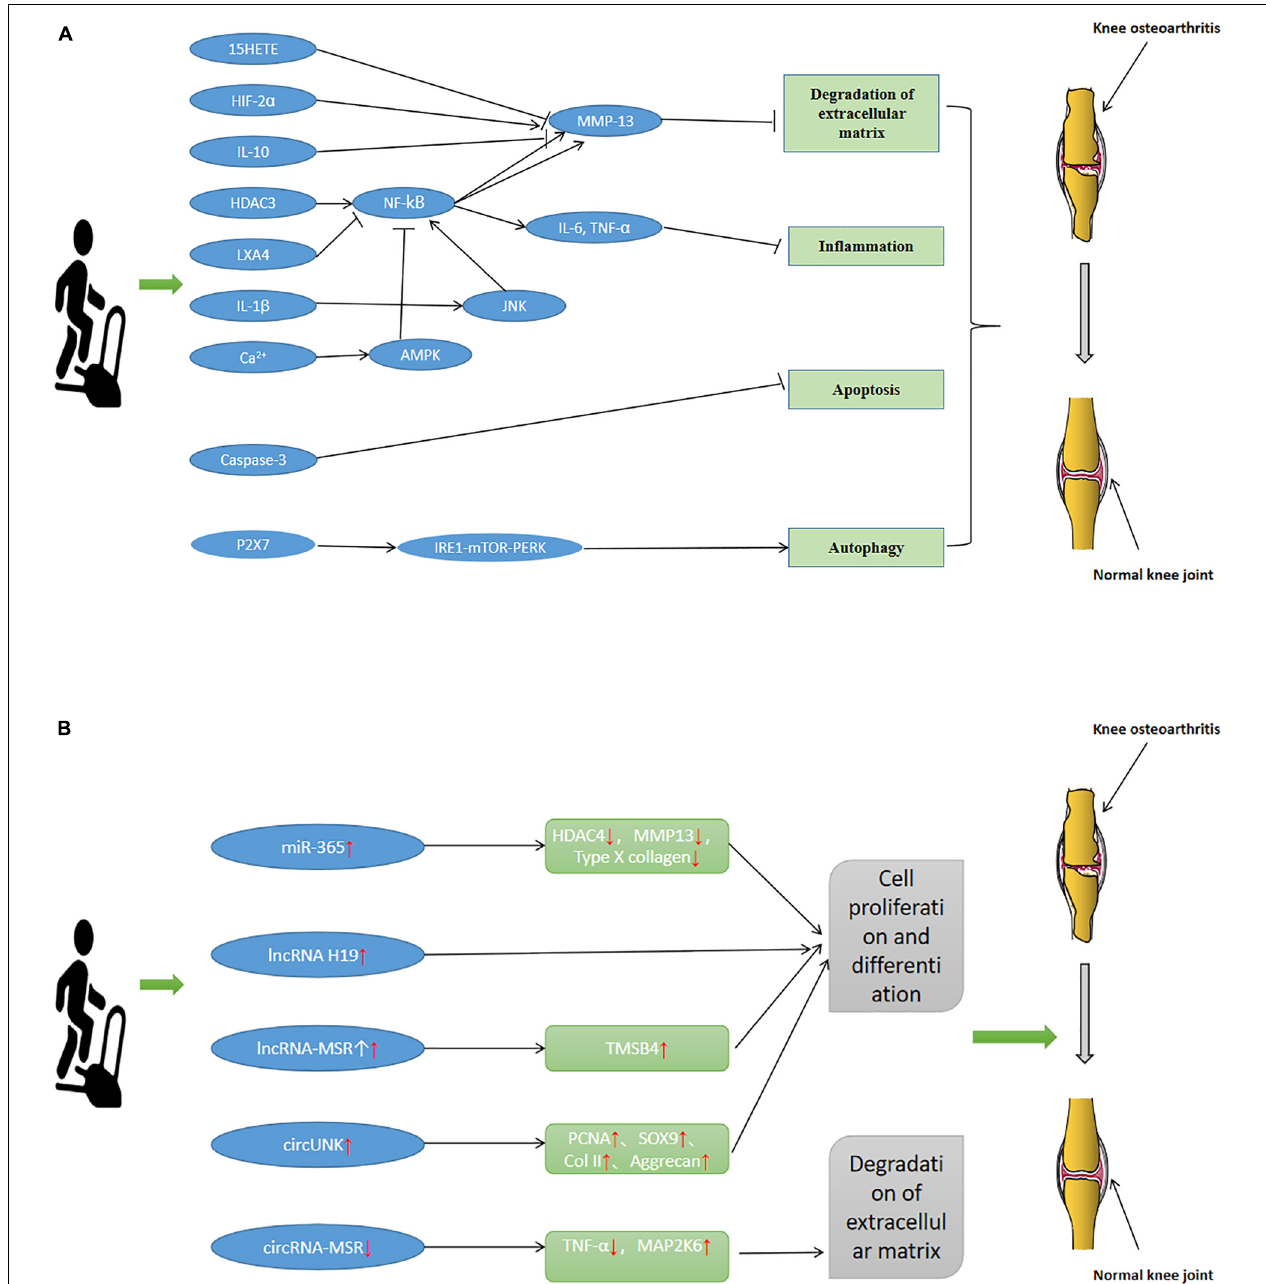
FIGURE 2 | Pathological change mechanism of Osteoarthritis (OA). Exercise relieves the pathological changes of OA by affecting the degradation of the ECM, apoptosis, inflammatory response, autophagy and changes of ncRNA. (A) Mechanism of pathological changes of OA through degradation of ECM, apoptosis, inflammatory response, and autophagy. (B) Mechanism of pathological changes of OA through